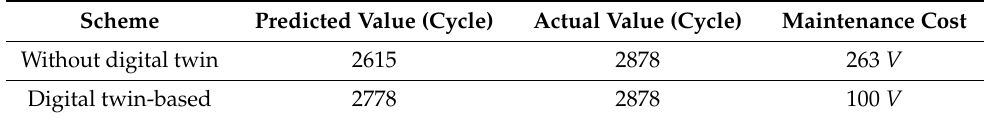
Figure 15. The results of model evolution of L1 batteries. Table 10. Life prediction and maintenance cost analysis of L1 batteries.